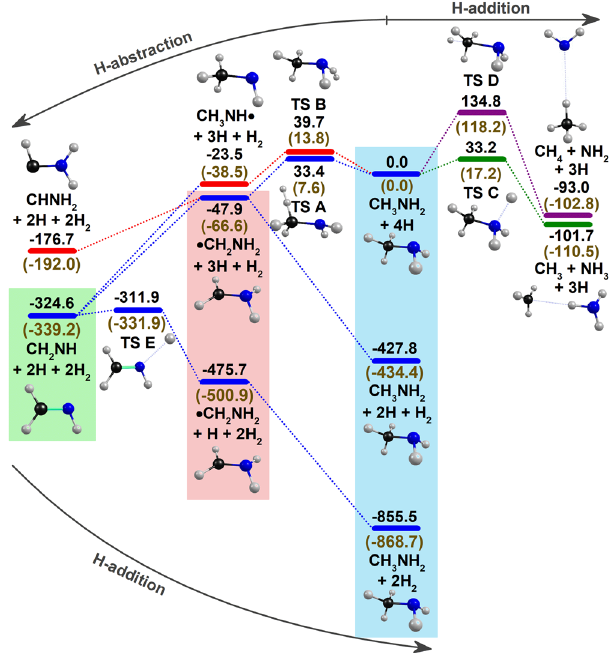
Fig. 2 Potential-energy scheme of H-addition and H-abstraction of CH 3 NH 2 calculated with the CCSD(T)/aug-cc-pVTZ//B3LYP/aug-cc- pVTZ method. Energies corrected for zero-point vibrational energy (ZPVE) are in kJ mol − 1 ; those calculated with the B3LYP/aug-cc-pVTZ methods are listed in parentheses for